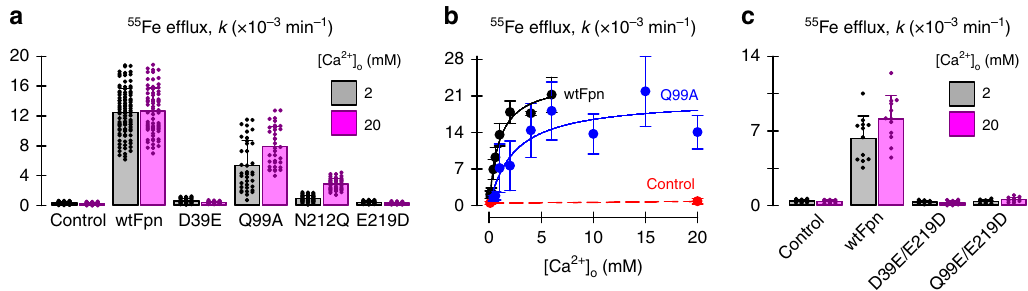
Fig. 6 Mutagenesis of putative Ca 2 + -coordinating residues in human Fpn. a 55 Fe ef fl ux from control oocytes and oocytes expressing wildtype or mutant Fpn in media containing 2 or 20 mM Ca 2 + ( n = 77, 54, 96, 69, 37, 35, 37, 35, 56, 39, 34, 29, left to right). Two-way ANOVA: interaction, P < 0.001; Q99A and N212Q differed from control ( P < 0.001) but D39E and E219D did not differ from control ( P ≥ 0.78). Raising [Ca 2 + ] o from 2 to 20 mM increased 55 Fe ef fl ux for Q99A and N212Q ( P ≤ 0.001) but not for any other mutant ( P ≥ 0.61). Relative expression levels were estimated from GFP fl uorescence (Supplementary Fig. 7A). b 55 Fe ef fl ux from control oocytes (red, n = 22) and oocytes expressing wildtype Fpn (black, n = 62) or Q99A (blue, n = 76) as a = 0.9 ± (SEM) 0.1 mM, V k = (24 ± function of [Ca 2 + ] o (i.e. 6 – 9 oocytes at each concentration). Data were fi t by Eq. (2): wildtype Fpn, K Ca max occurred at 0 : 5 = 2.4 ± 0.4 mM, V k = (20 ± 1) × 10 − 3 min − 1 ( r 2 = 0.83, P < 0.001). c 55 Fe ef fl ux 1) × 10 − 3 min − 1 ( r 2 = 0.97, P < 0.001); and Q99A, K Ca max occurred at 0 : 5 from control oocytes and oocytes expressing wildtype or mutant Fpn ( n = 12, 11, 12, 12, 11, 12, 12, 10). Two-way ANOVA: interaction, P = 0.009; neither mutant differed from control at either 2 or 20 mM Ca 2 + ( P ≥ 0.76). Raising [Ca 2 + ] o from 2 to 20 mM increased 55 Fe ef fl ux for wildtype Fpn ( P < 0.001) but not for either mutant ( P ≥ 0.73). All bar graphs indicate mean, SD, and individual scores; data in b are mean, SD